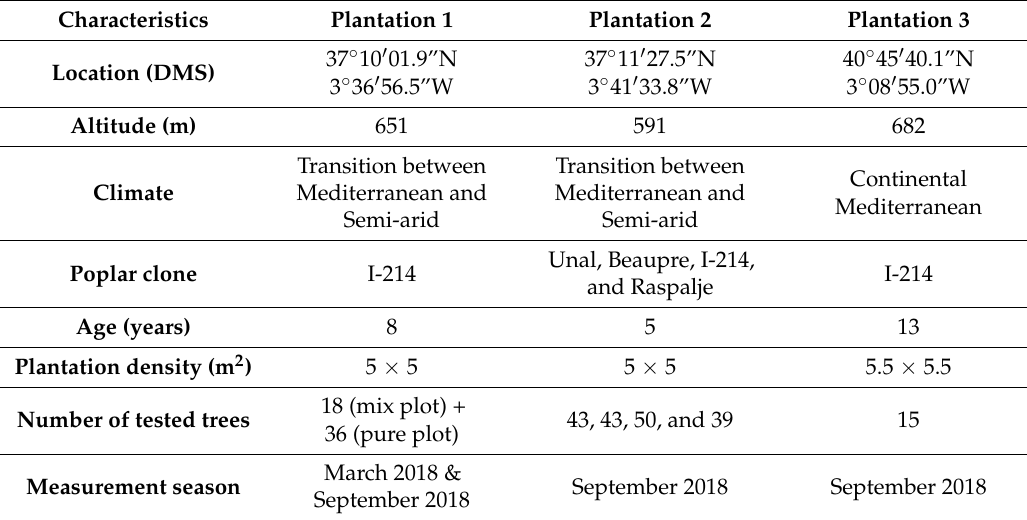
Table 1. Characteristics of the different